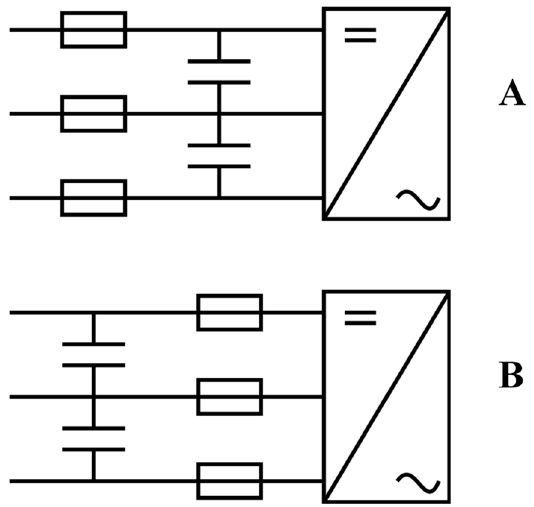
Figure 6. Topologies for the position of the fuses. The fuses could be installed on the dc-link side at